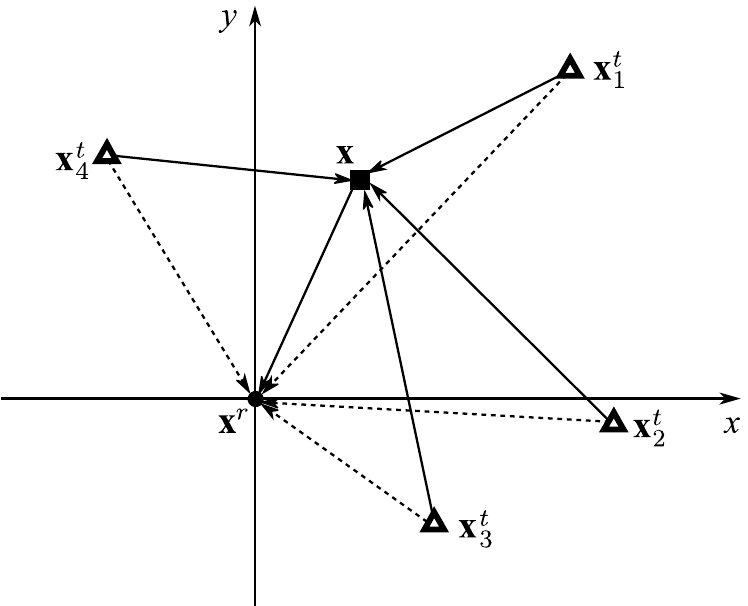
Figure 1. Passive target localization using noisy TDOA